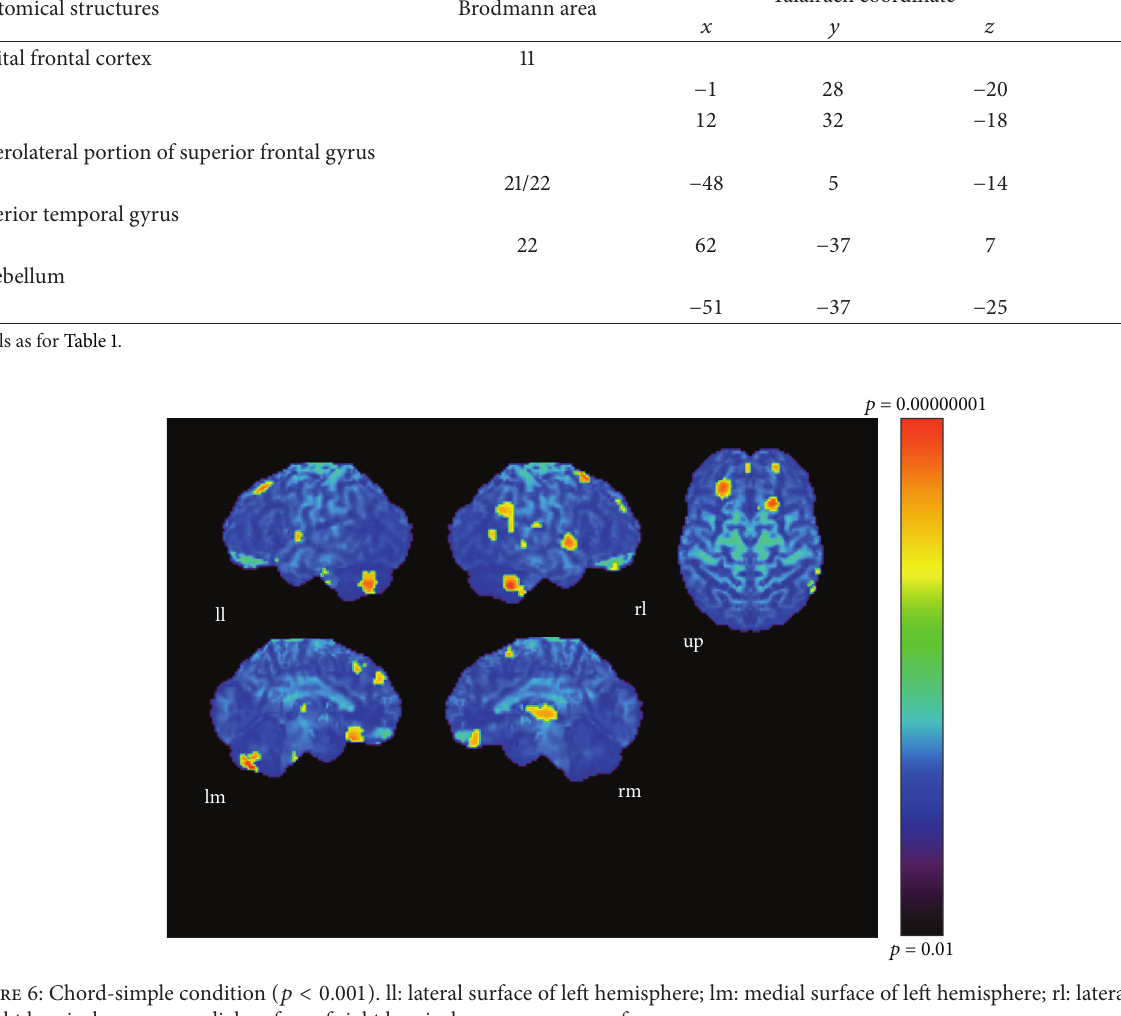
Figure 6: Chord-simple condition ( 𝑝 < 0.001 ). ll: lateral surface of left hemisphere; lm: medial surface of left hemisphere; rl: lateral surface of right hemisphere; rm: medial surface of right hemisphere; up: upper